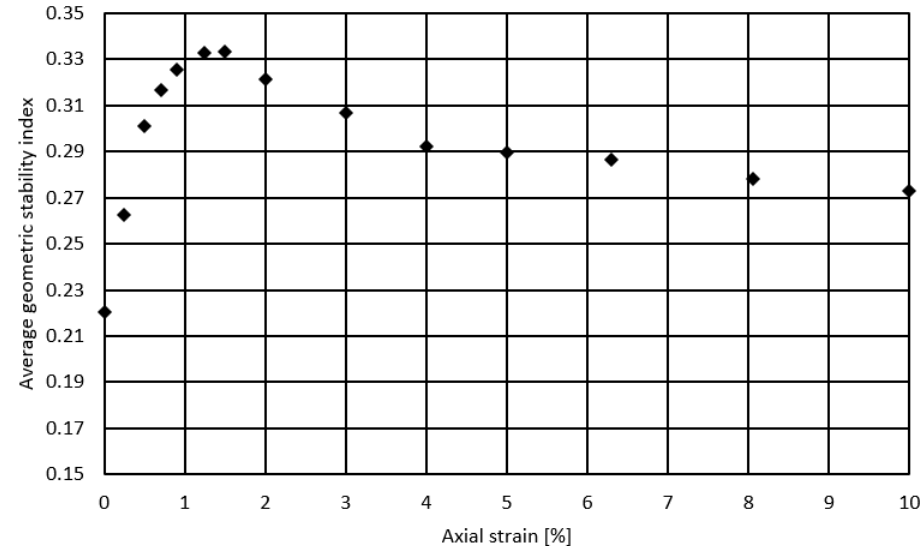
Figure 14. Average geometry stability index with axial strain.